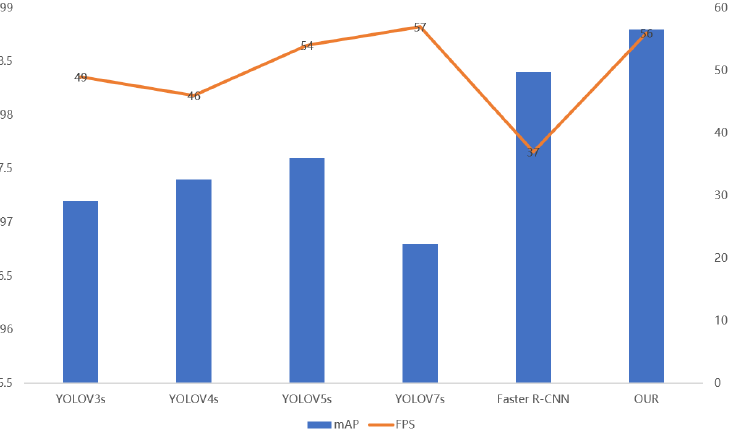
Figure 14. In the comparison of mAP and FPS values of different detectors, the horizontal axis represents different detectors, the left half of the vertical axis represents mAP values, and the right half of the vertical axis represents FPS values.